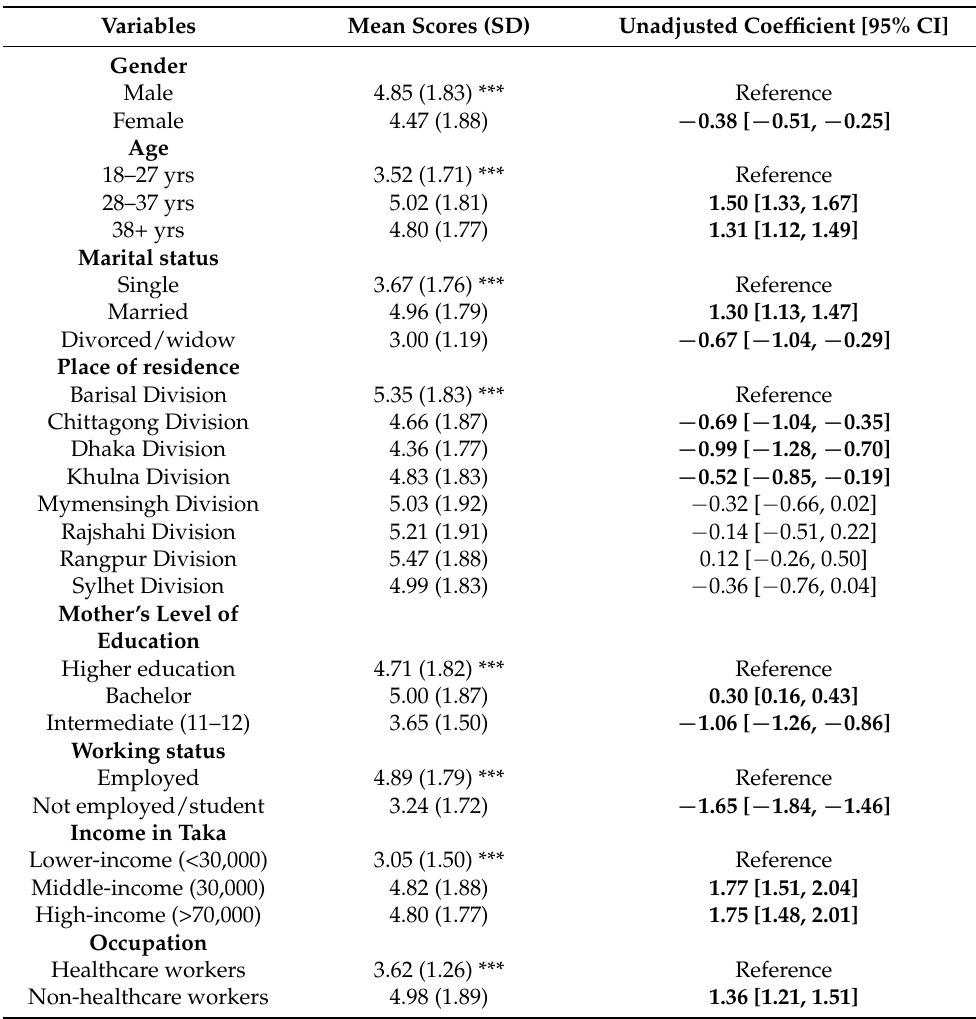
Table 3. Mean of physical complaints depending on internet use. Results of separate simple linear